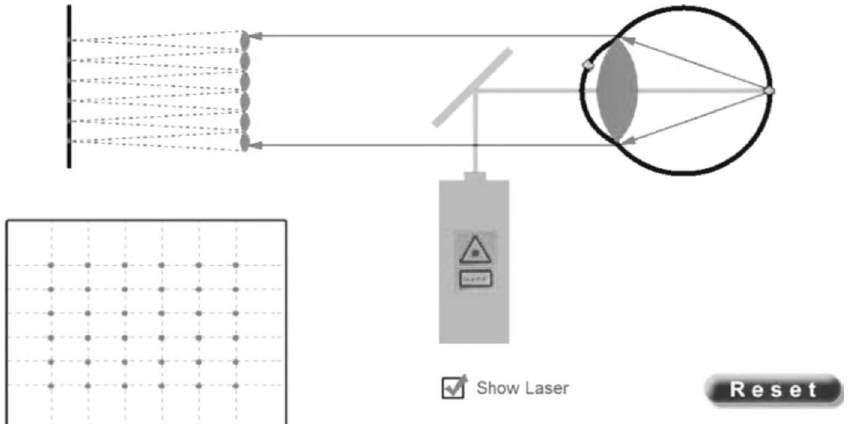
FIG. 1. Computer simulation used to illustrate